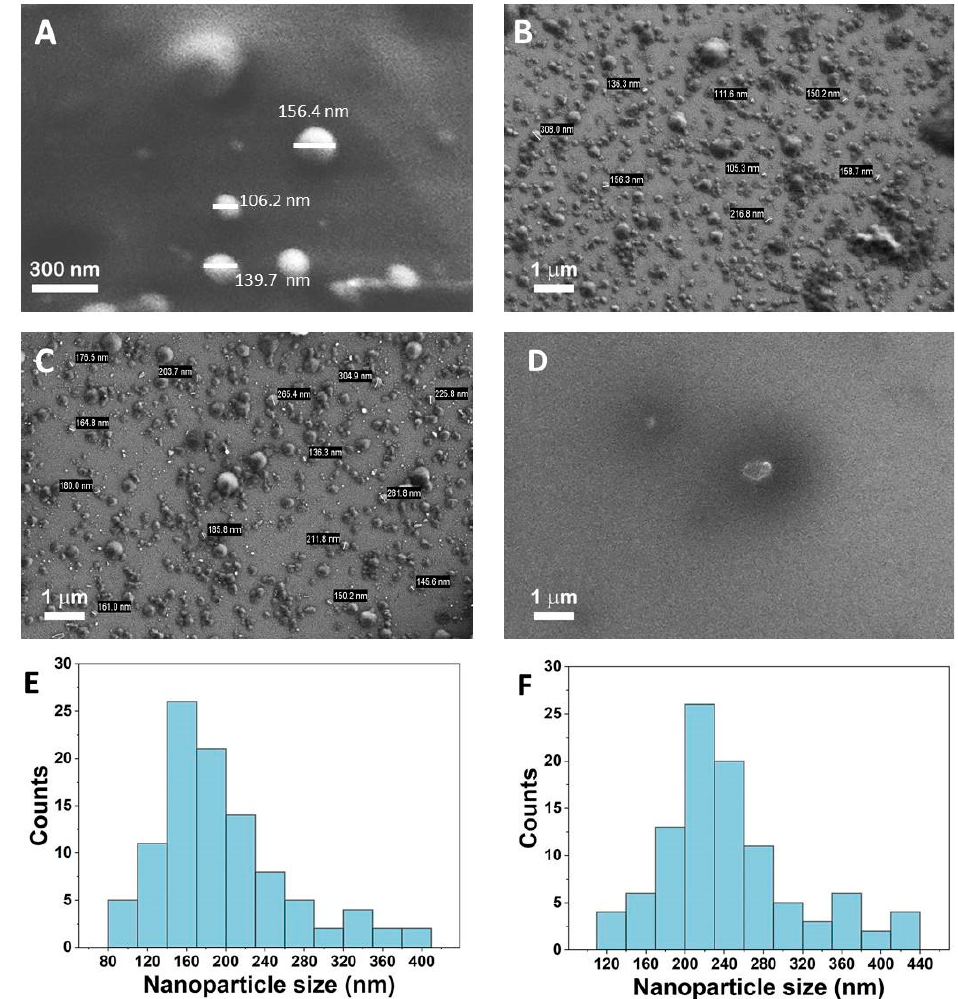
Figure 5. SEM micrographs of the BSA NPs(1) ( A ), BSA NPs(2) ( B ), BSA NPs(3) ( C ) and BSA NPs(4) ( D ); size distribution for BSA NPs(3) ( E ); and size distribution for BSA NPs(2) ( F